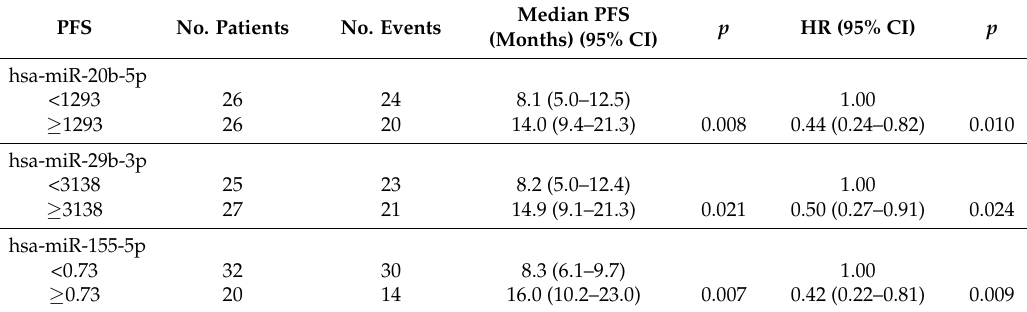
Table 5. Univariate analysis of PFS and OS in relation to miRNA cutoff